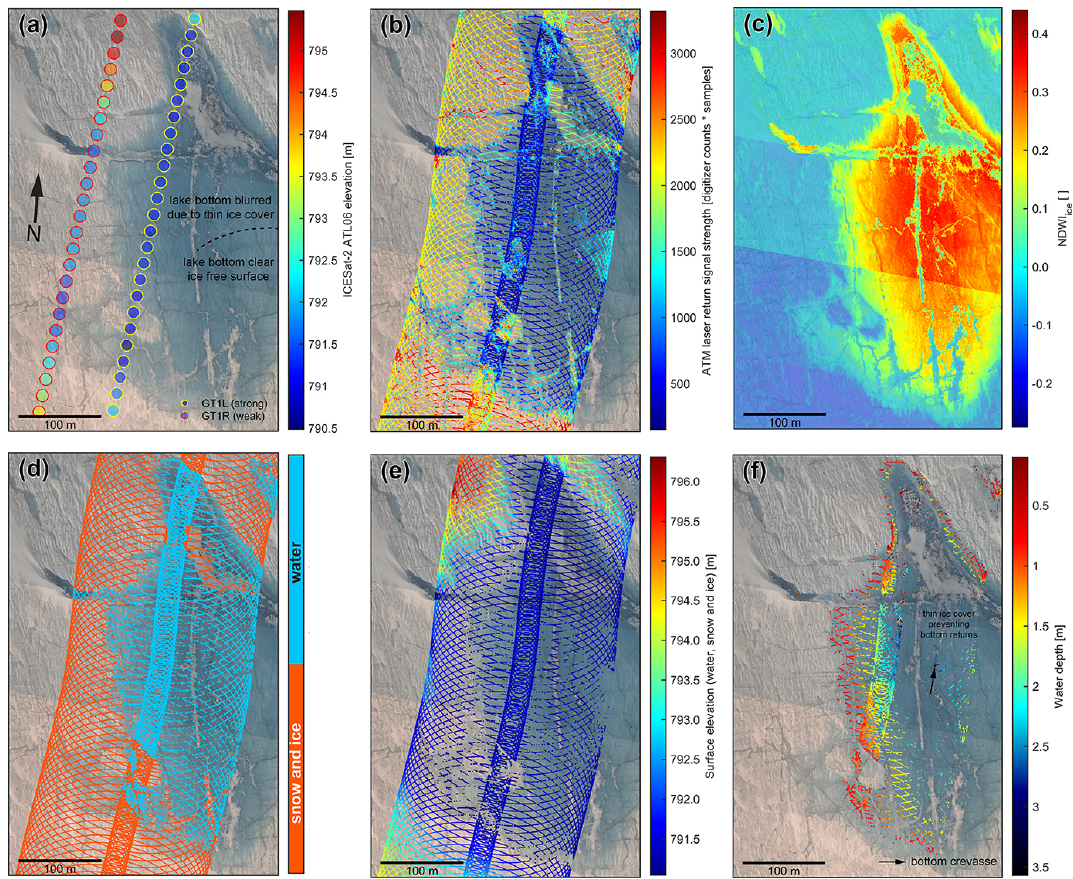
Figure 8. (a) Mosaic of five geolocated, orthorectified CAMBOT natural color images of a supraglacial lake. ICESat-2 data were acquired 3h after the ATM pass over the lake on 15 May 2019. (b) Return signal strength of the ATM T6 and T7 laser footprints. The return signal strength is significantly lower over the lake compared to the surrounding snow and ice surface. (c) NDWI ice plotted over CAMBOT image mosaic with NDWI ice pixels below the detection threshold of 0.05 shown at 50% opacity. (d) Surface classification of ATM laser footprints based on NDWI ice pixels using a classification threshold of 0.05. (e) Surface elevation of laser footprints over snow and ice. (f) Water depth of hydrological features. For location see Fig. 2. Surface temperature and surface melt indicator from MODIS (Hall et al., 2018; Hall and DiGirolamo, 2019), as well as number of melt days for this location, are shown in Fig.